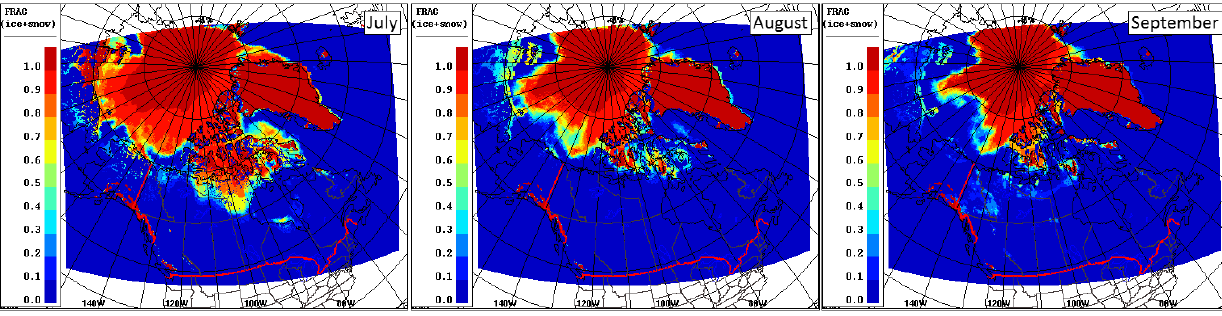
Figure 20. Monthly averaged ice and snow fraction for July, August, and September